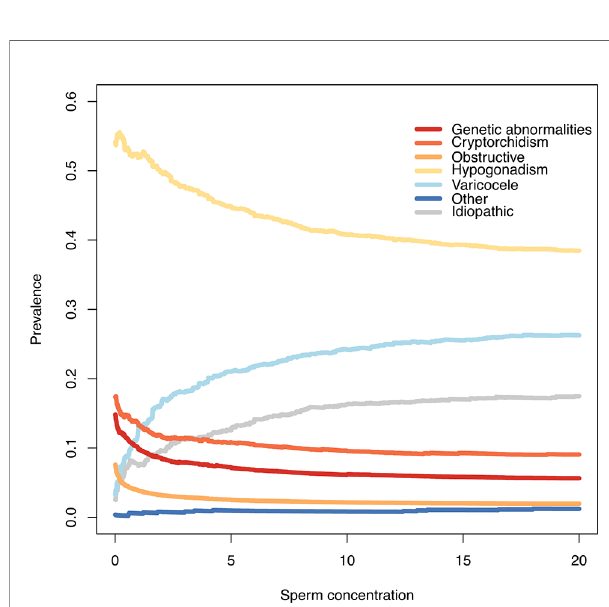
FIGURE 2 | Prevalence of different causes of male factor infertility according to different sperm concentration thresholds. At each sperm concentration threshold (x axis) is shown on the y-axis the relative proportion of men with a speci fi c causal factor (eg: if x=5, on the y-axis is shown cause prevalence of men with sperm concentration < 5 million/ml).